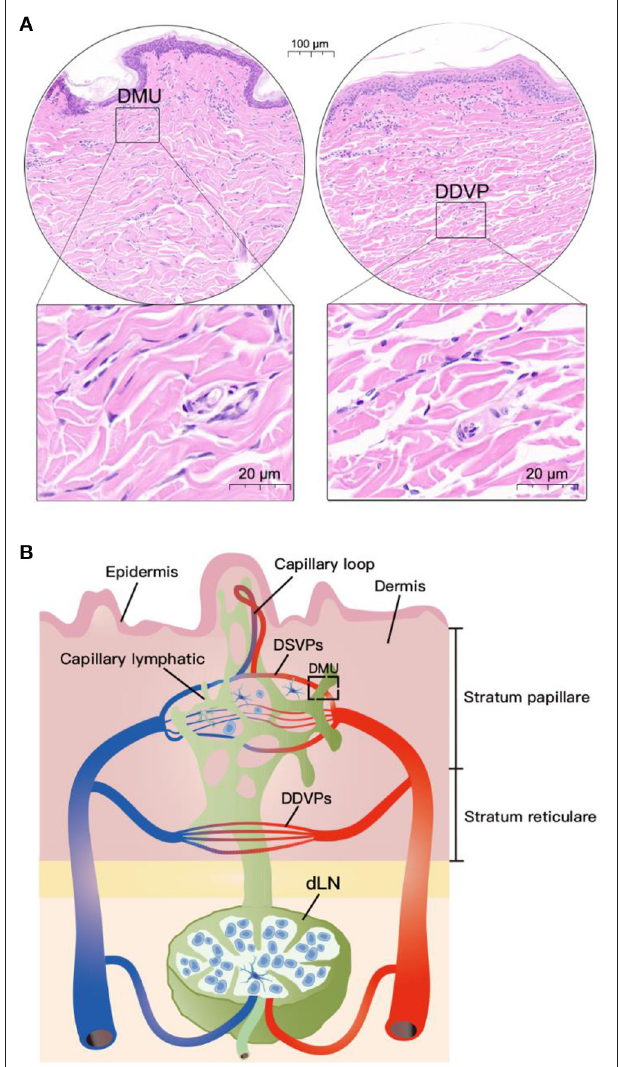
FIGURE 1 | Location of DMUs in the skin with HE staining. (A) Localization of DMUs as well as DDVPs in the skin; (B) Describe the distribution and structure of DMUs in the skin. DMU, dermal microvascular unit; DSVPs, dermal superficial vascular pleauxes; DDVPs, deep dermal vascular plexuses; dLN, draining lymph node; Scale bar in circular region denotes 100 µ m and scale bar in square area denotes 20 µ